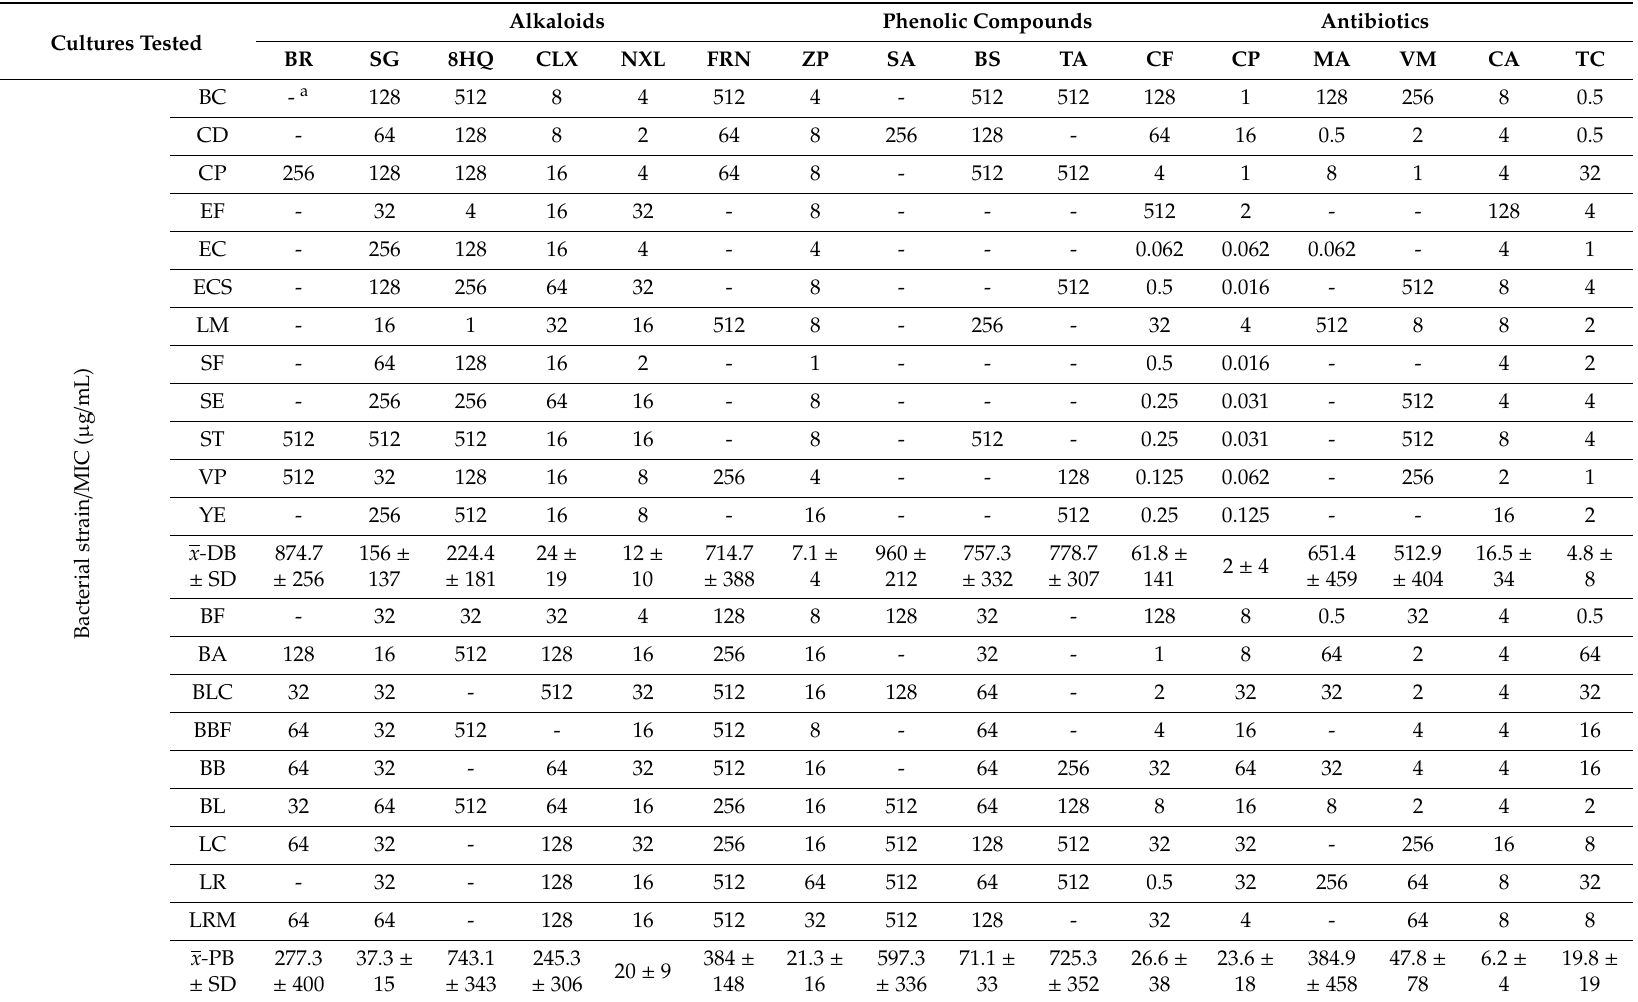
Table 1. In vitro selective inhibitory activities of phytochemicals, their synthetic analogs, and antibiotics against intestinal bacteria and cells. Cultures